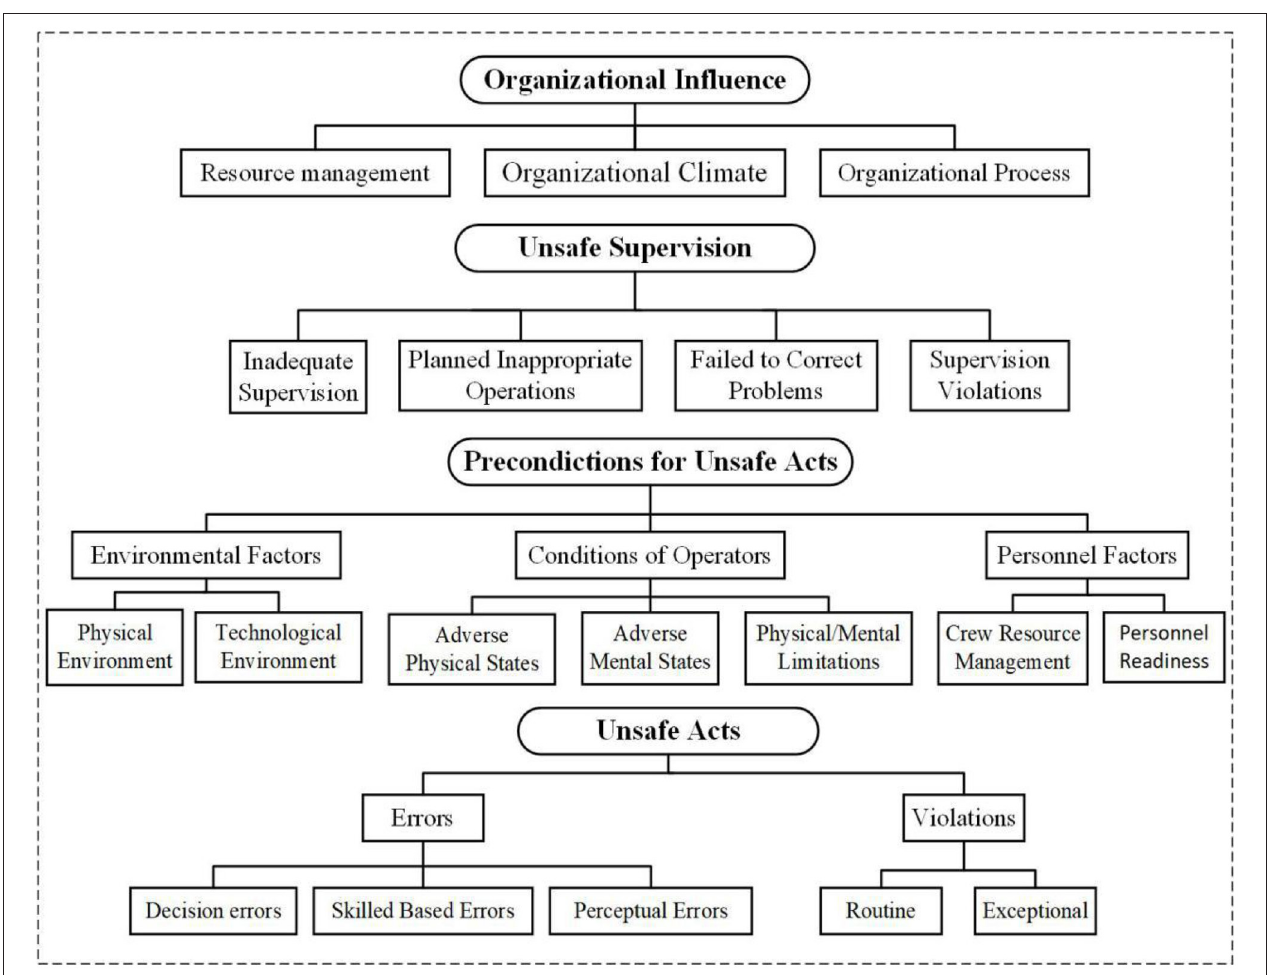
FIGURE 1 | The original HFACS